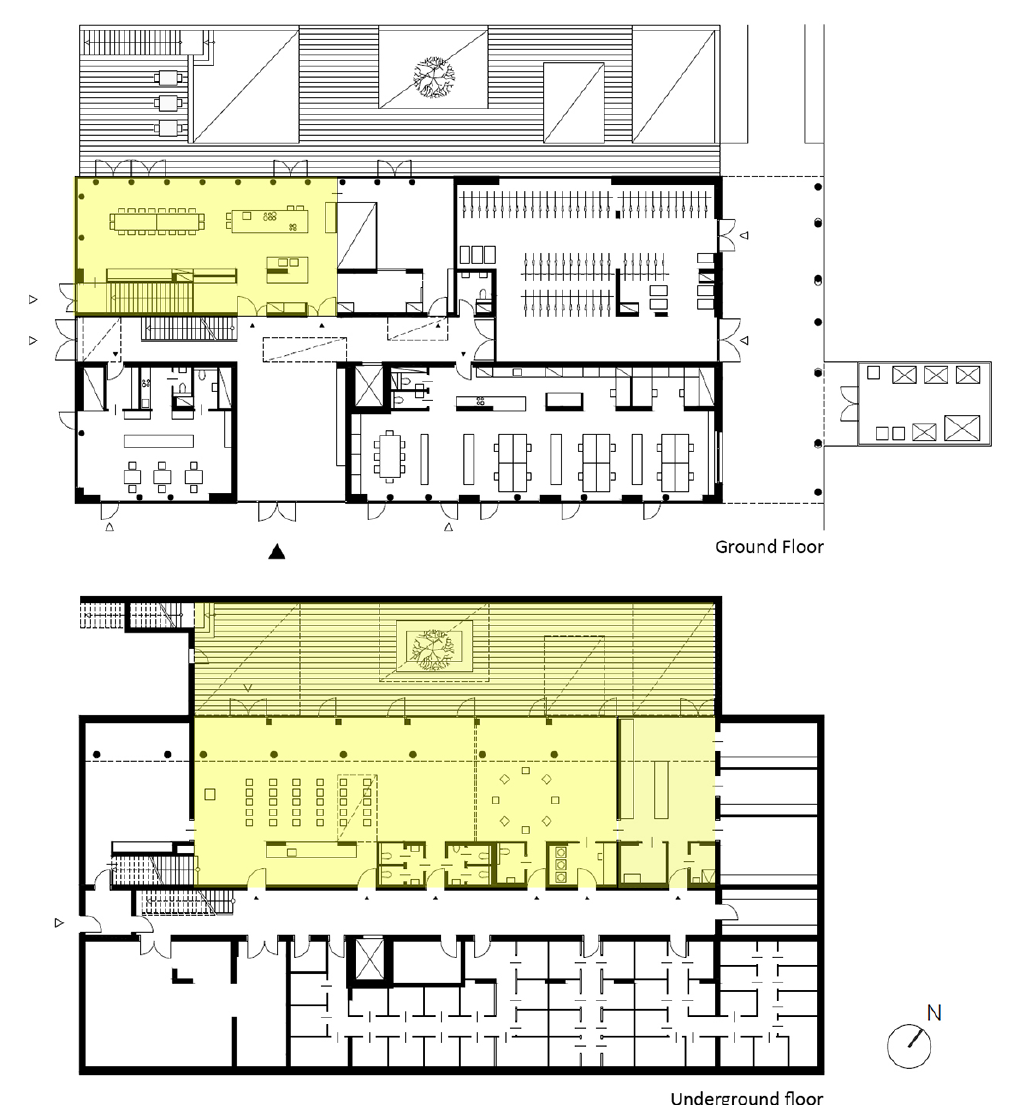
Figure 16. Wohnprojekt Wien (plans of ground and underground floors), Vienna, 2013, by Einszueins Architekten. Image courtesy of Einszueins Architekten. Note: The communal kitchen and the multi-purpose rooms can be used or rented by external groups.